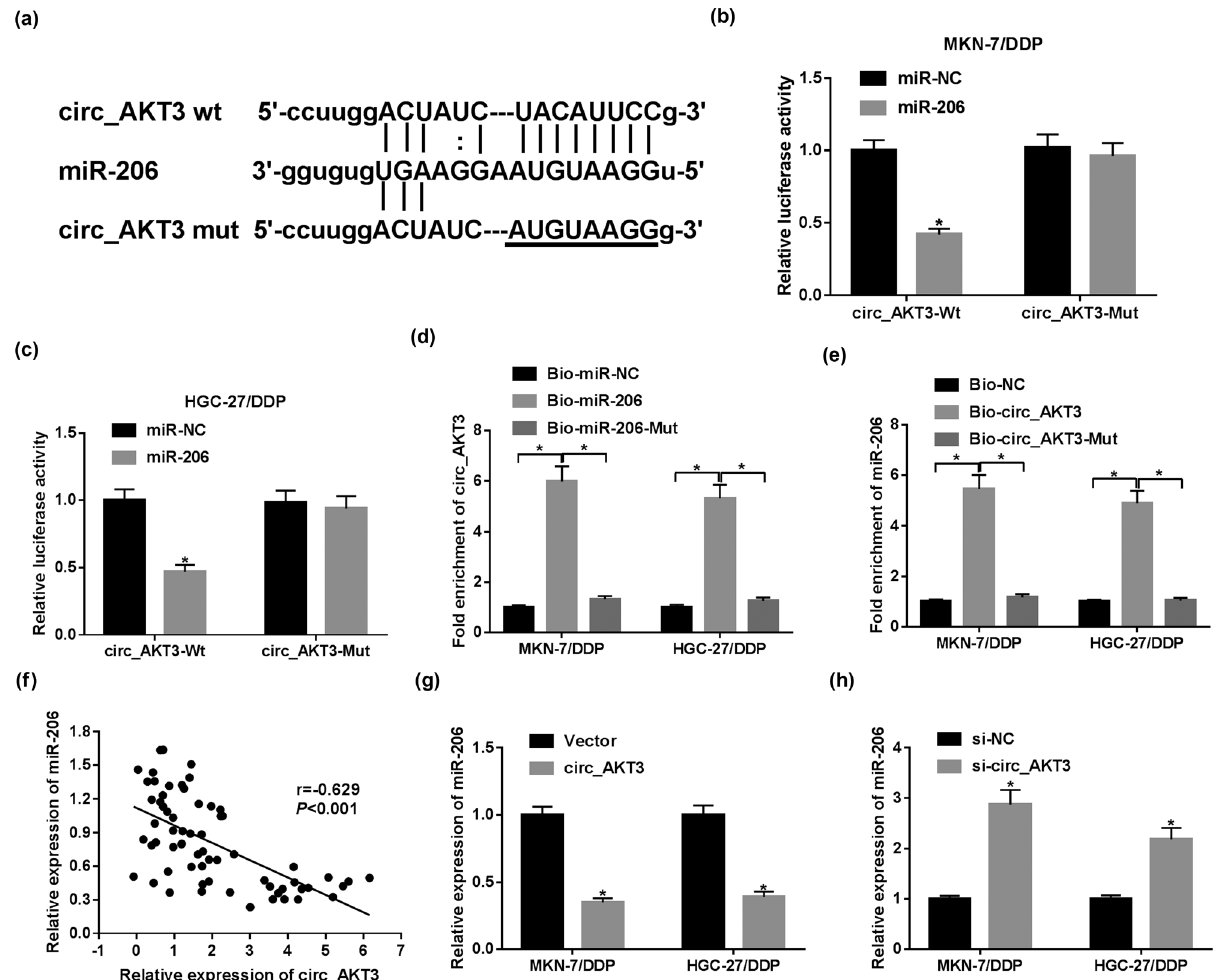
Figure 4: circ_AKT3 is a decoy of miR - 206. ( a ) The potential complementary sites of circ_AKT3 and miR - 206 were analyzed via starBase. ( b and c ) Luciferase activity was detected in MKN - 7/DDP and HGC - 27/DDP cells co - transfected with miR - NC or miR - 206 mimic and circ_AKT3 - Wt or circ_AKT3 - Mut. ( d and e ) The levels of circ_AKT3 and miR - 206 were detected in MKN - 7/DDP and HGC - 27/DDP cells after biotin pull - down. ( f ) The linear correlation between expression of circ_AKT3 and miR - 206 in GC tissues was analyzed. ( g and h ) miR - 206 level was detected in MKN - 7/DDP and HGC - 27/DDP cells transfected with vector, circ_AKT3 overexpression vector, si - NC or si - circ_AKT3 via RT - qPCR. * P <